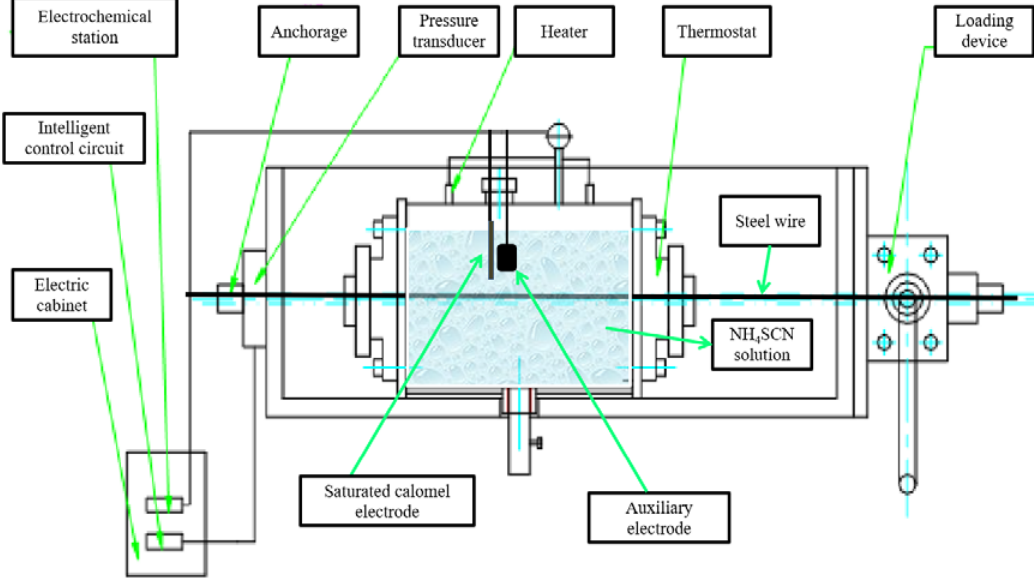
Figure 1. Experimental setup for accelerated corrosion tests for prestressed wires.